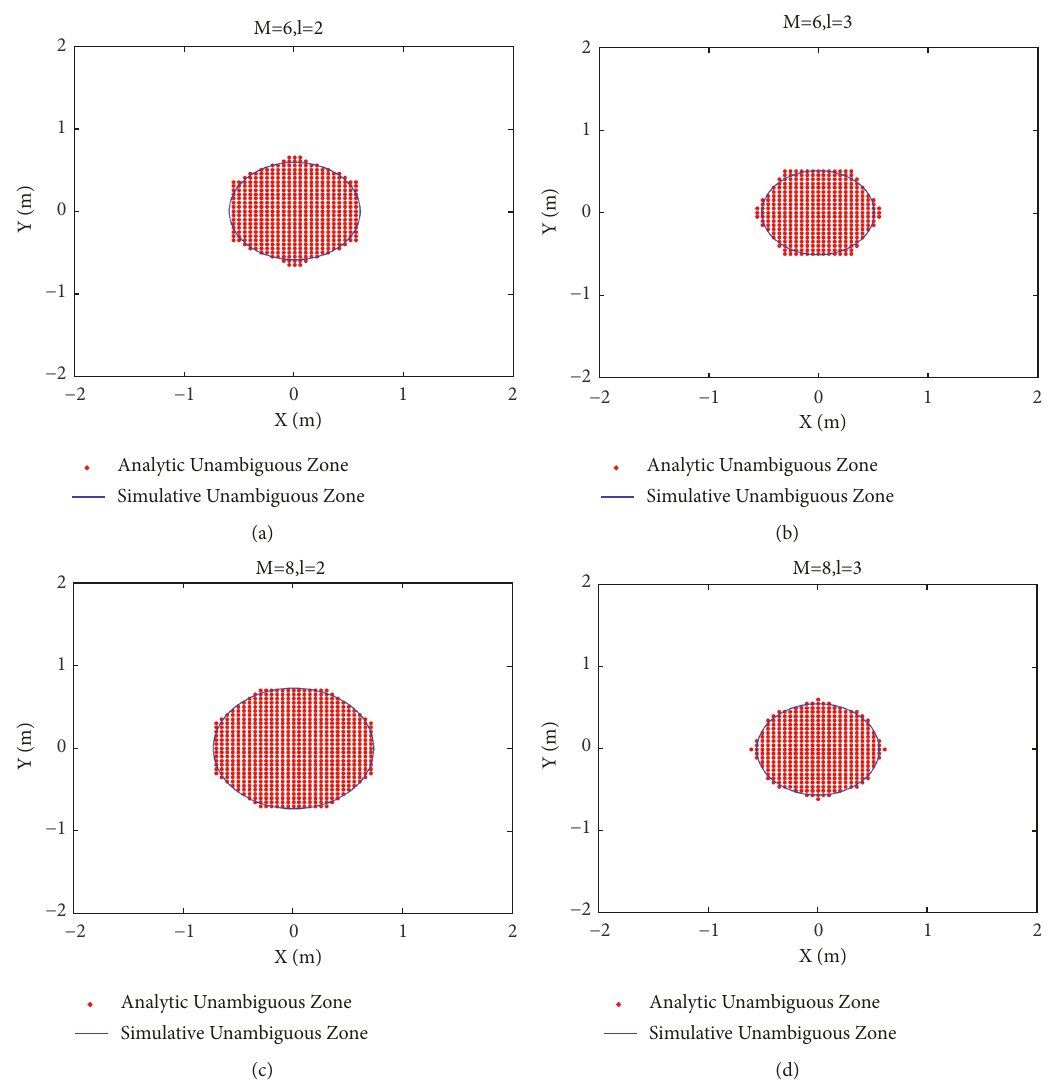
Figure 4: Comparison of unambiguous parameter estimation zones in the Z-plane. (a) Unambiguous zone under 𝑀 = 6, 𝑙 = 2 . (b) Unambiguous zone under 𝑀 = 6, 𝑙 = 3 . (c) Unambiguous zone under 𝑀 = 8, 𝑙 = 2 . (d) Unambiguous zone under 𝑀 = 8, 𝑙 = 3